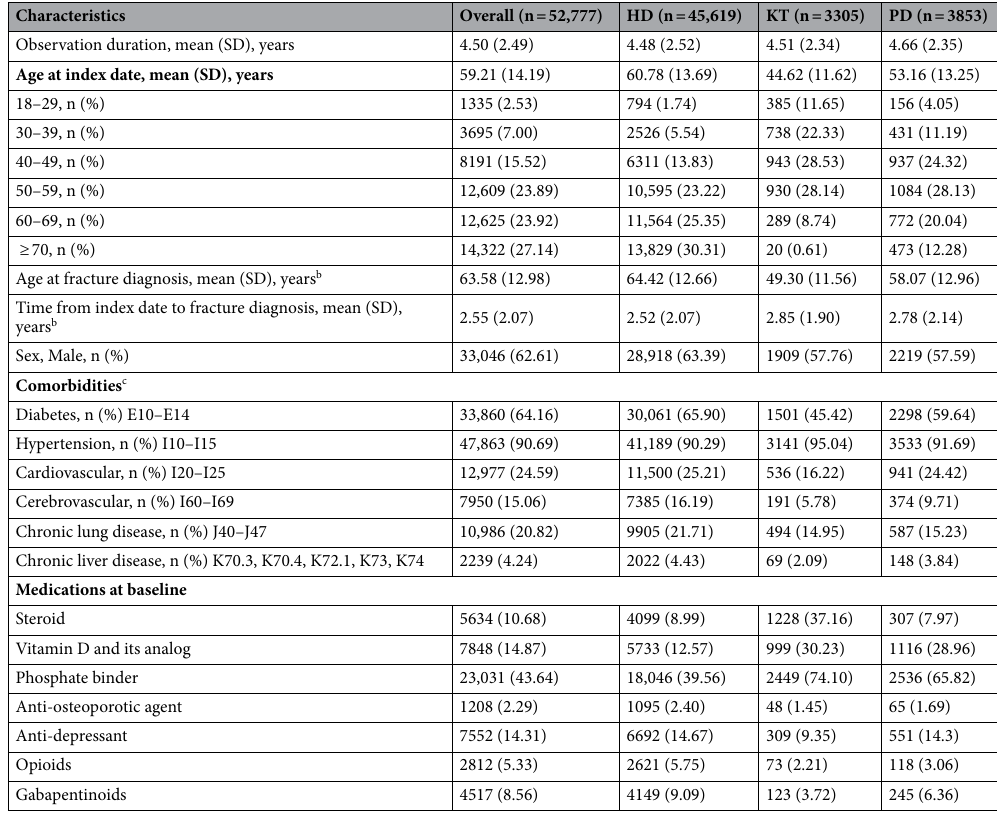
Table 1. Demographic characteristics of the study population stratified by kidney replacement therapy. a P value was based on analysis of variance (ANOVA), otherwise chi-square test. b Analyzed in patients with fracture (n = 8995) only. c Comorbidities and medications were observed 1 year before index date; dialysis date or kidney transplant date. HD hemodialysis, KT kidney transplant, PD peritoneal dialysis, SD standard